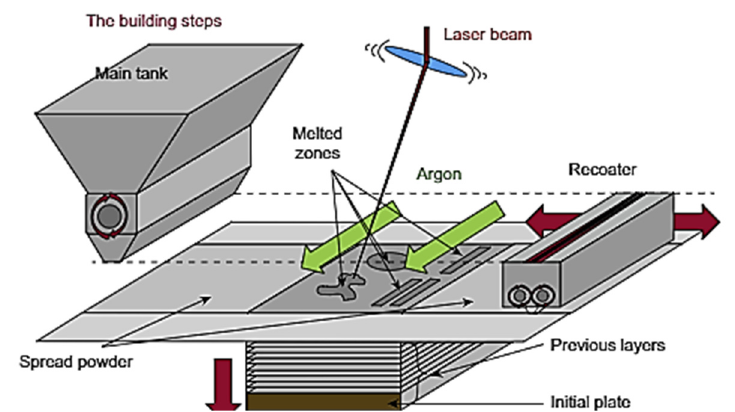
Figure 1. AM technologies classification according to ISO/ASTM 52900 [3].